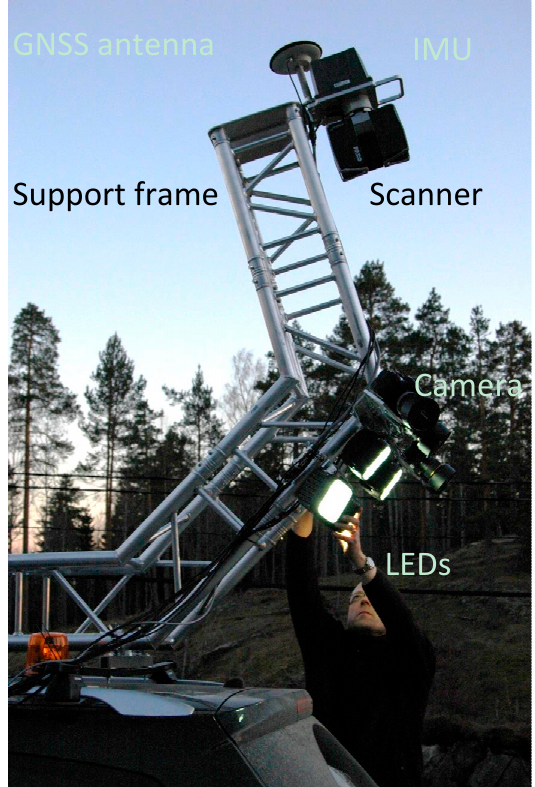
Figure 7. RoamerR2 mounted for road environment mapping using GlobalTruss frame for elevating the scanner to 3.4 m above the road surface beneath. The profile is tilted 15 degrees. LED lights could be used to light the road surface for image capture in the dark.